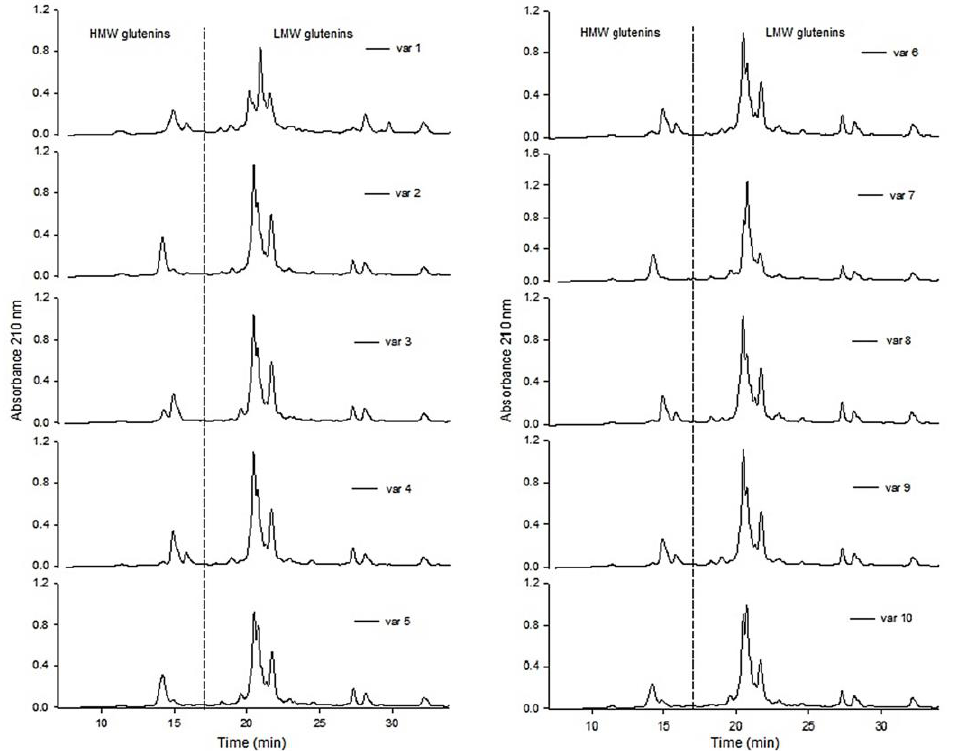
Figure 4. RP-HPLC profiles of glutenins (propanol/urea/DTE extracts) for the studied wheat varie- ties.